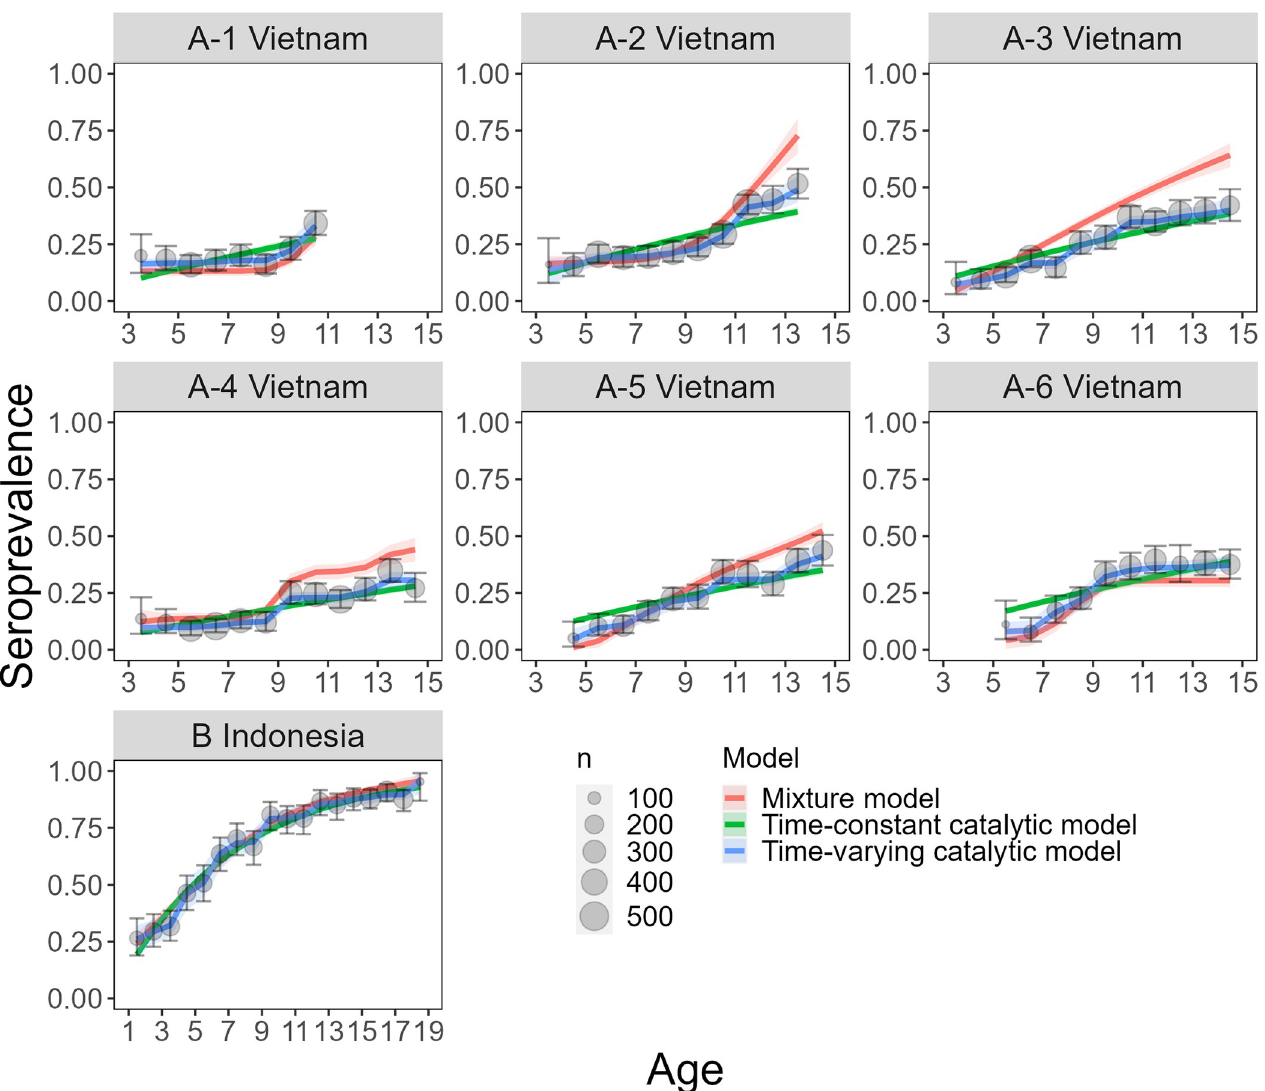
Fig 5. Age-specific seroprevalence estimates for the IgG data from Vietnam (Dataset A1:A6) and from Indonesia (Dataset B). Mixture model estimates are in orange, catalytic model estimates are in green and blue when applied under the assumption that the FOI is time-constant or time-varying respectively. Shading represents the 95% Confidence Intervals (CI). The grey points show the observed seroprevalence per age group calculated from the binarily classified IgG data (seropositive individuals / tested individuals), with error bars indicating the 95% exact binomial CIs. The seroprevalence data and model estimates are overlayed for the purpose of comparison. However, it is important to note that the mixture model was not fitted to the data (grey points), as the former does not depend on the titre classification. The size of the grey data points represents the number of individuals tested in each age